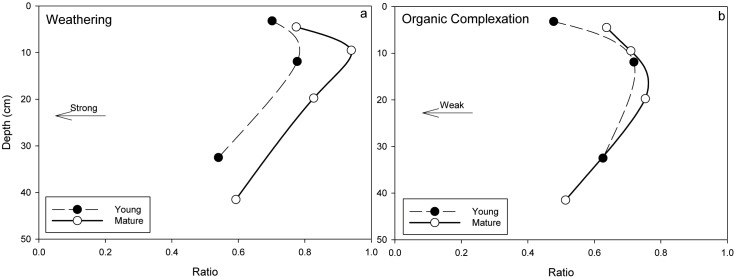
Plot of pedogenic ratios for Young (solid line) and Mature (broken line) through depth, which are indexes of a) weathering; and b) organic complexation. Note that strong weathering is indicated by a low ratio in a). In both diagrams, the site with stronger complexation or weather has a darker line.